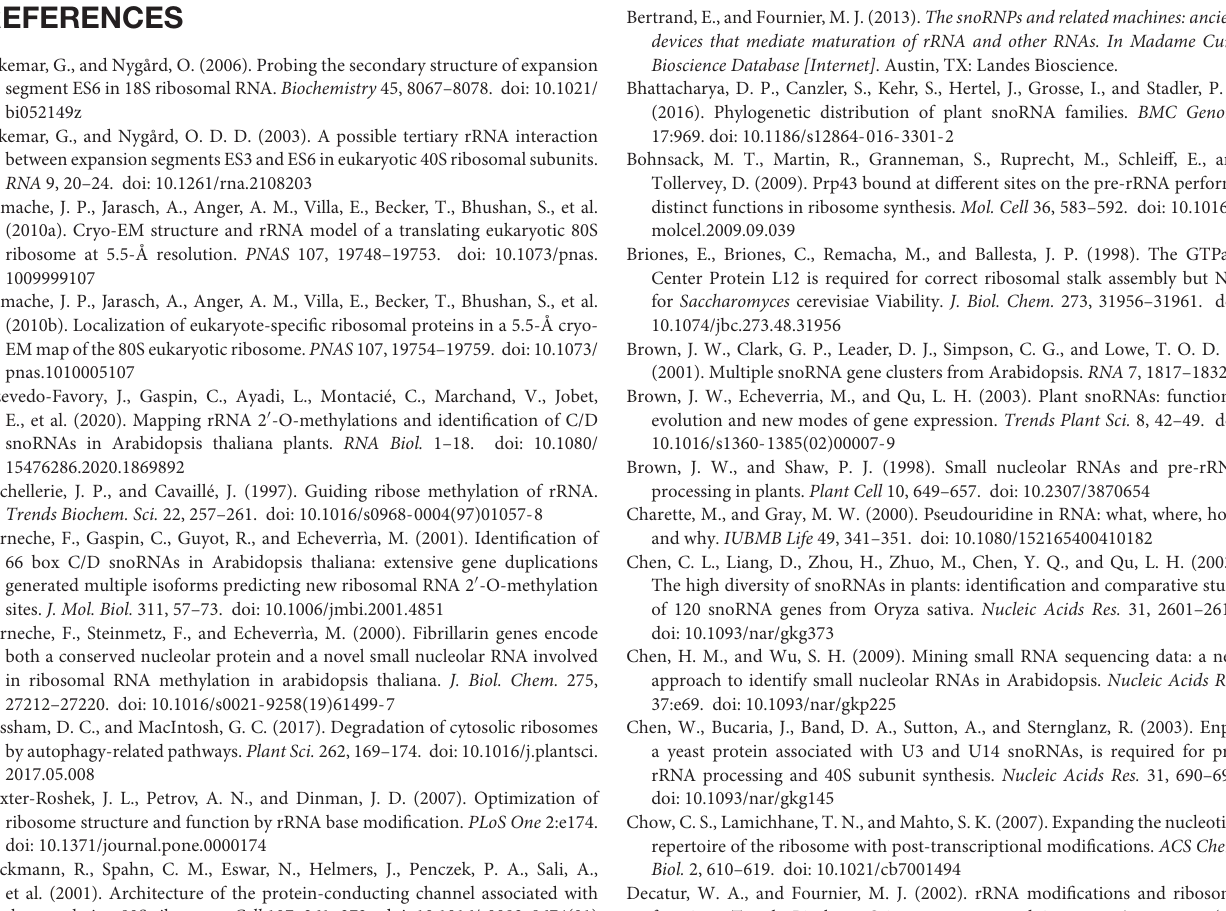
sites. Not determined (nd).